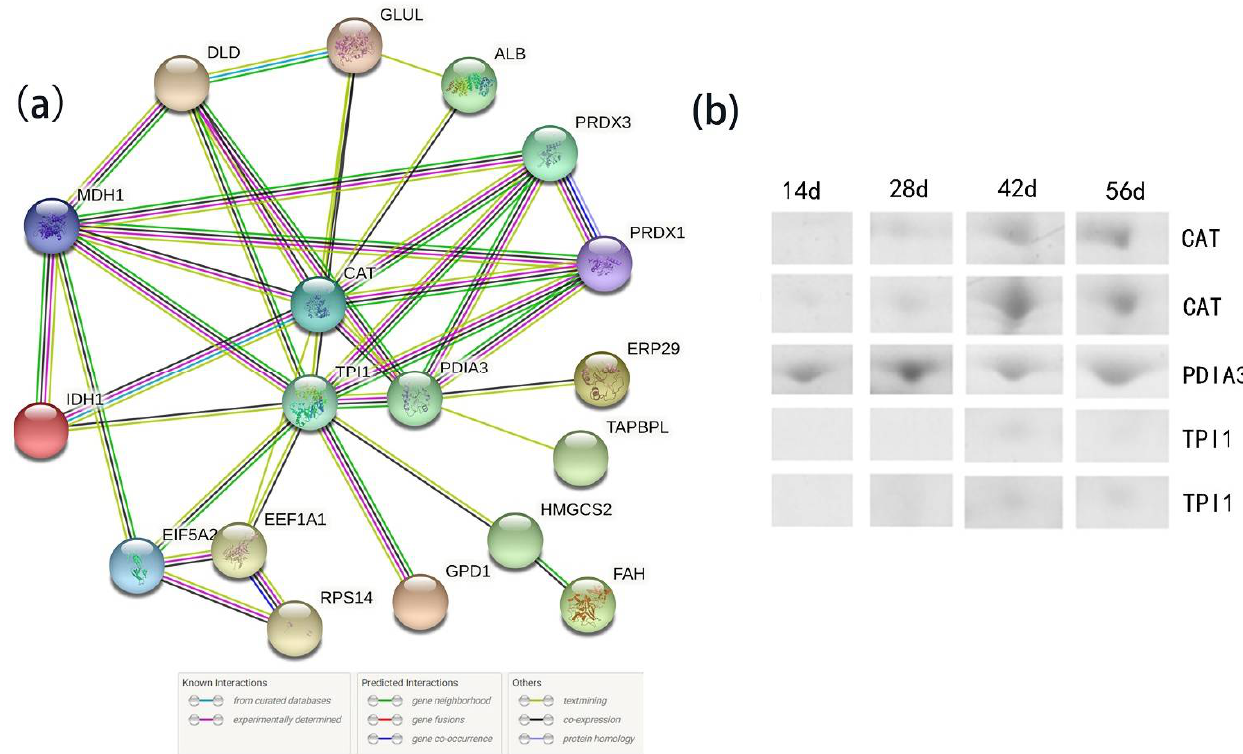
Figure 6. ( a ) The biological interaction network of the proteins for all differentially expressed proteins; ( b ) The expression level of node proteins in 2D electrophoresis gels, day (d). Note: CAT, catalase; TPI1, triosephosphate isomerase; PDIA3, protein disulfide-isomerase; ERP29, endoplasmic reticulum protein 29; TAPBPL, glyceraldehyde-3-phosphate dehydrogenase; HMGCS2, 3-hydroxy-3-methylglutaryl coenzyme A synthase; FAH, fumarylacetoacetase; GPD1, glycerol-3-phosphate dehydrogenase; EEF1A1, elongation factor 1-alpha; RPS14, ribosomal protein S14; EIF5A2, eukaryotic translation initiation factor 5A; IDH1, isocitrate dehydrogenase; MDH1, malate dehydrogenase; DLD, dihydrolipoyl dehydrogenase; GLUL, glutamine synthetase; ALB, albumin; PRDX3, Peroxiredoxin 3; PRDX1, Peroxiredoxin 1.